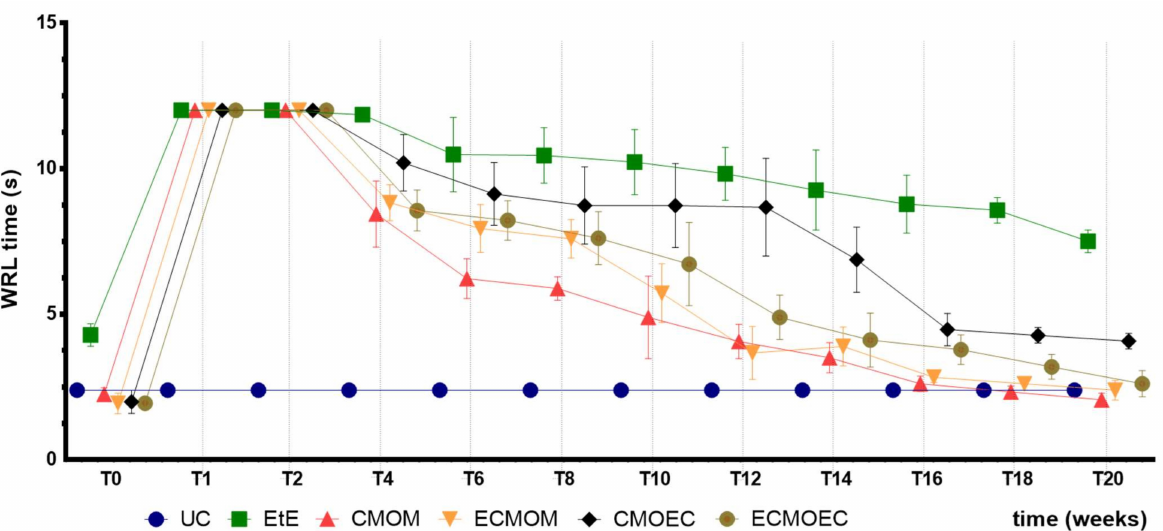
Figure 6. WRL values (s) over the 20-week recovery period (mean ± SEM). After neurotmesis injury, a general increase in WRL time was observed in all therapeutic groups. After week 2, a progressive decrease in the WRL value was observed in all groups, and at 20 weeks, the lowest WRL value was identified in the CMOM